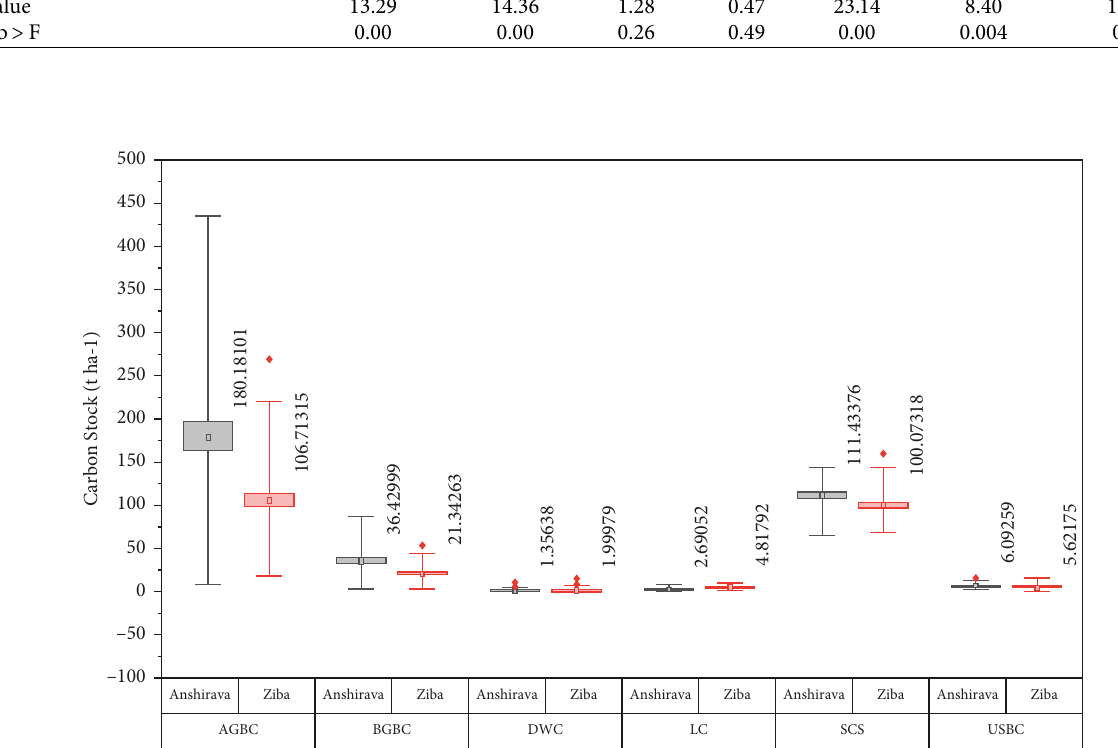
Figure 5: Carbon stock distribution of different carbon pools in studied